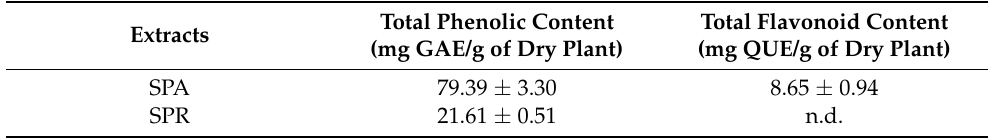
Table 1. Spectrophotometric determination of the total phenolic and flavonoid contents in the S. pratensis aerial part (SPA) and root (SPR)